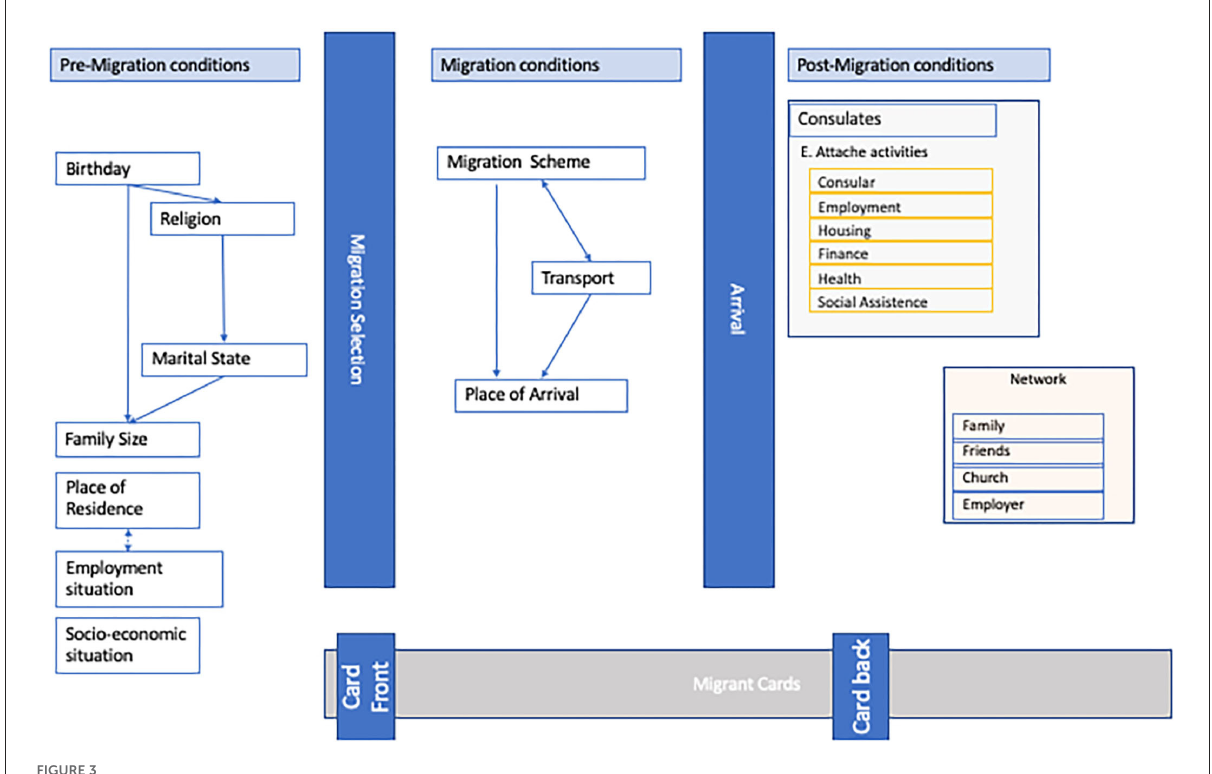
FIGURE3 Schema of influences on migrant registration